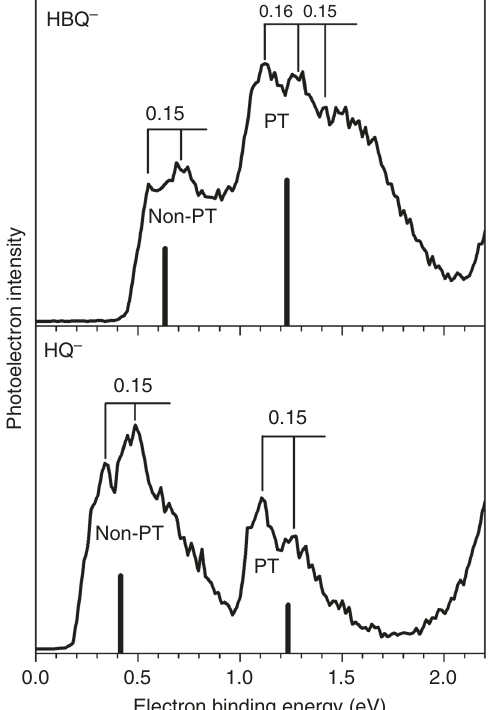
Fig. 1 Photoelectron spectroscopy. Photoelectron spectra of HBQ − and HQ − taken with a 532 nm laser. PT proton-transferred, Non-PT